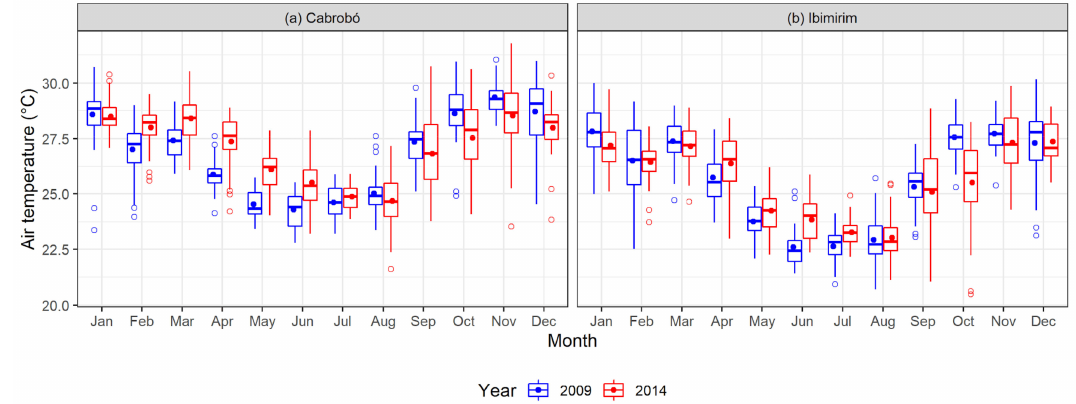
Figure 3. Monthly boxplots of hourly air temperature data in the Cabrob ó and Ibimirim sites in 2009 (wet year) and 2014 (dry year).